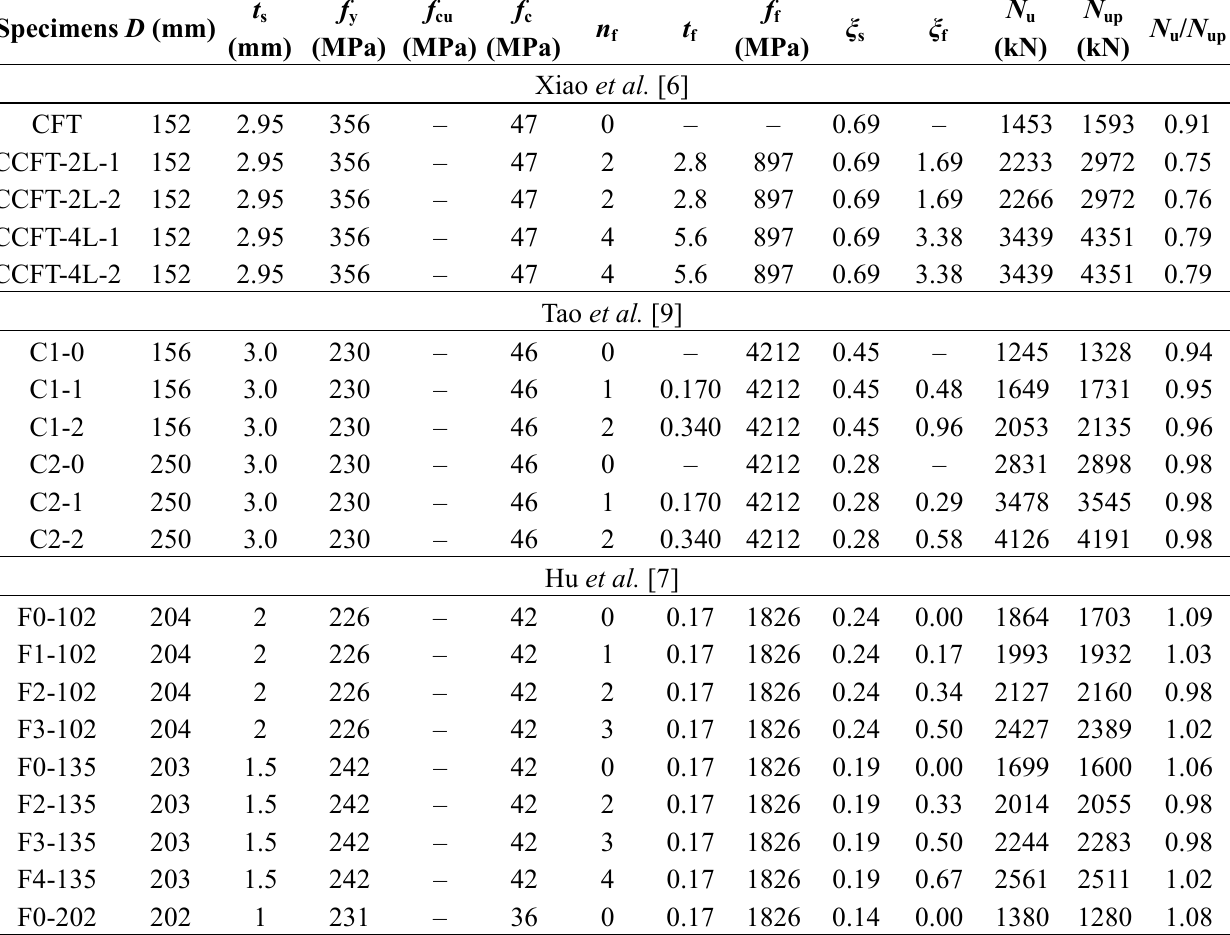
Table 4. Comparisons of the predicted and experimental ultimate